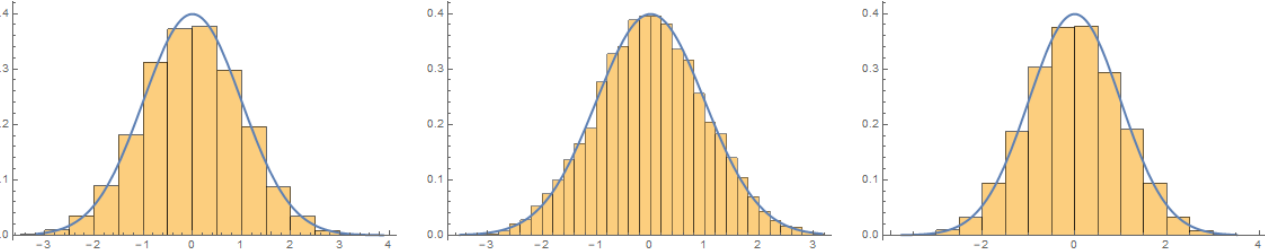
Figure 5. Plots of the cumulative distribution function (CDF) of list against the CDF of a normal distribution for κ 67 , κ 86 and κ 88 respectively.